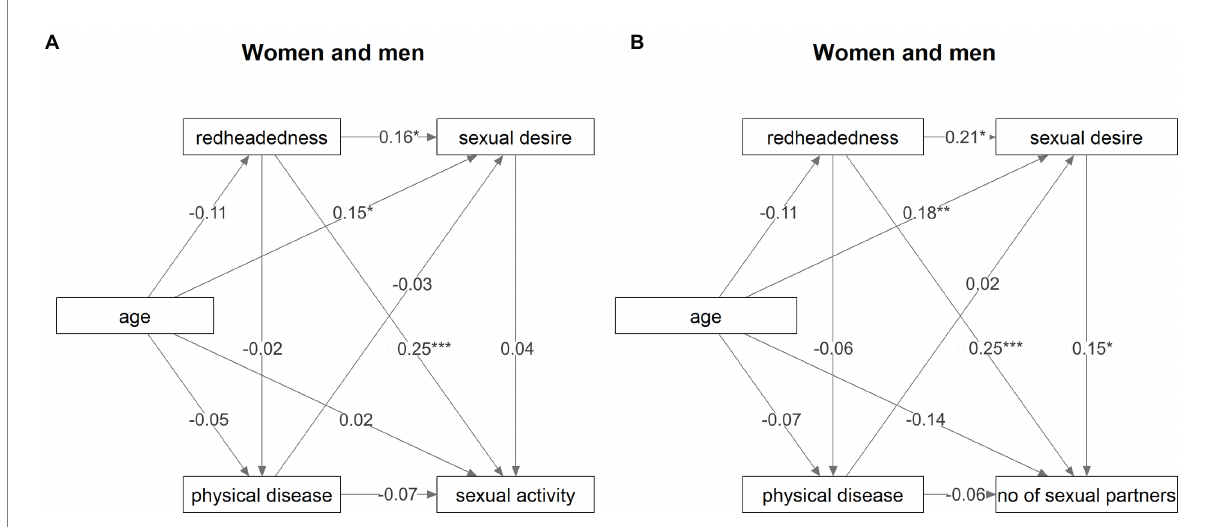
FIGURE 1 Direct and indirect effects of redheadedness on sexual activity and the number of sexual partners of the preferred sex. The figure visualizes the results of path analyses. Numbers at arrows show standardized parameter estimates. Associations with p values under 0.05 are marked by “*”, those with p values under 0.01 are marked by “**”, and those with p values under 0.001 are marked by “***”. (A) Relations between redheadedness and sexual activity in both women and men. (B) Relations between redheadedness and the number of sexual partners of the preferred sex in both women and